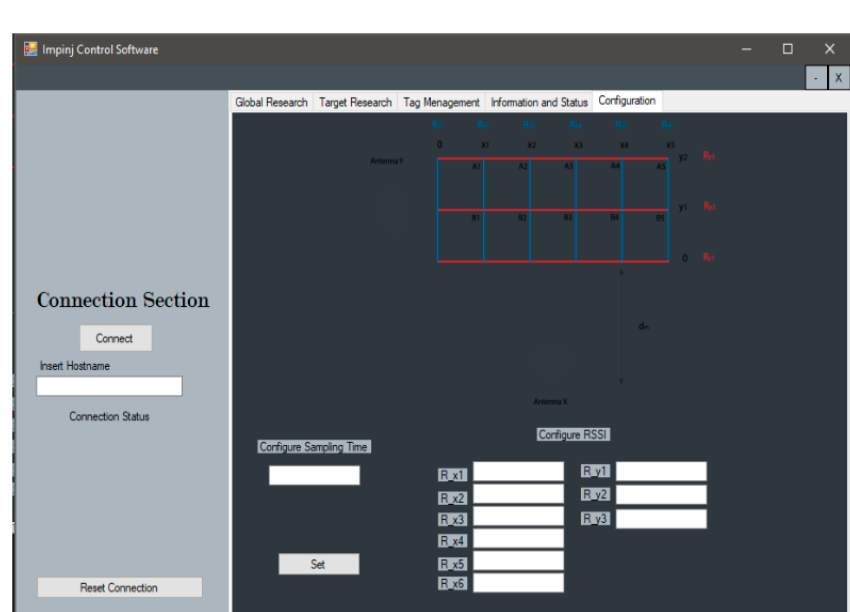
Figure 11. Reader control interface.